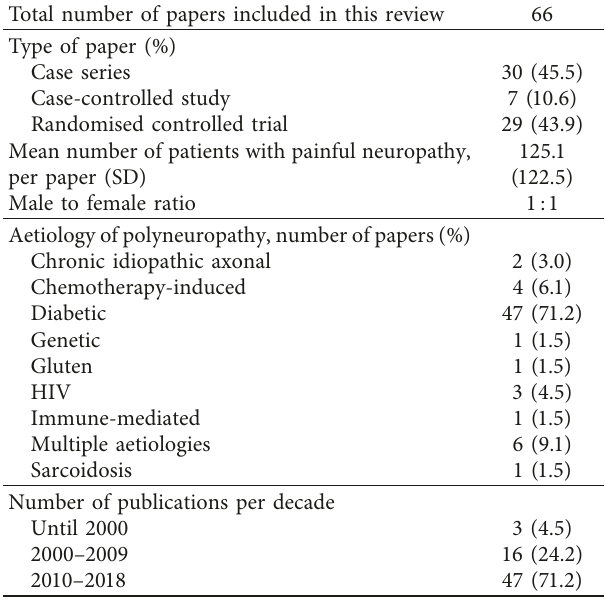
Table 1: Characteristics of the papers included in the